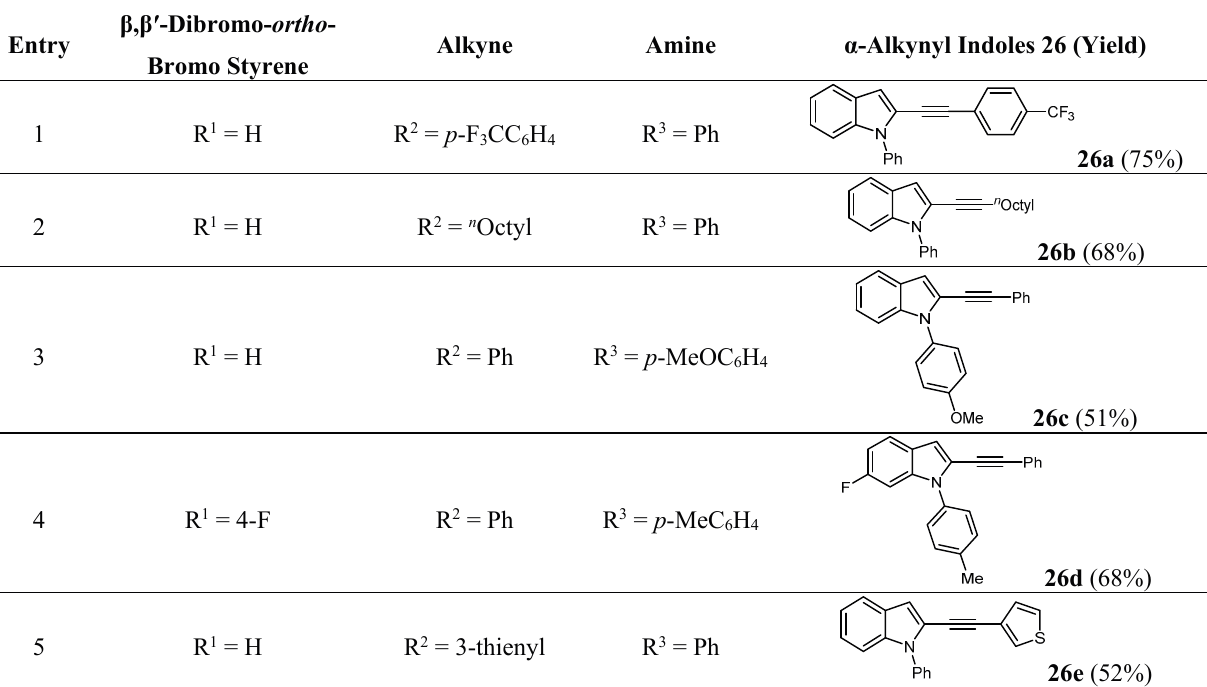
Scheme 17. Three-component synthesis of α -alkynyl indoles 26 via Sonogashira-inter- and intra-molecular Buchwald-Hartwig sequence. Table 8. Selected α -alkynyl indoles 26 via Sonogashira-inter- and intramolecular Buchwald-Hartwig